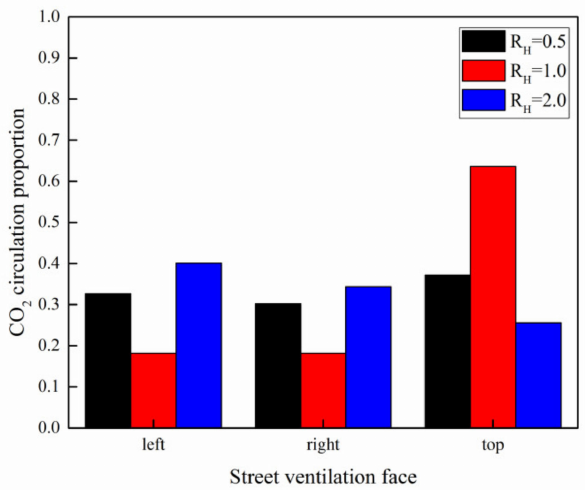
Figure 18. Flux proportion of pollutants per unit area of street ventilation surfaces with different height